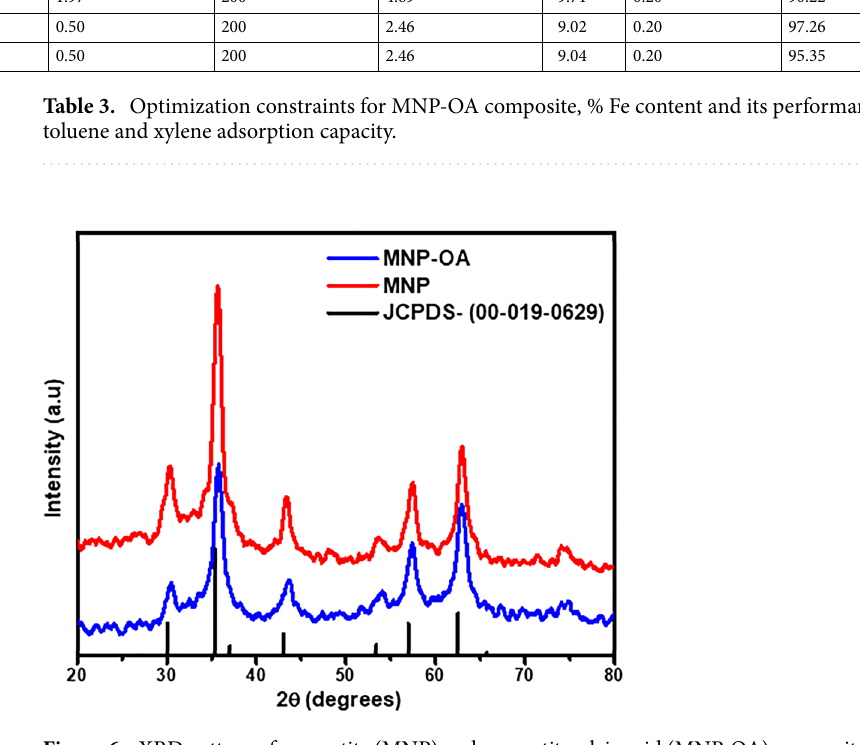
Figure 6. XRD pattern of magnetite (MNP) and magnetite-oleic acid (MNP-OA)